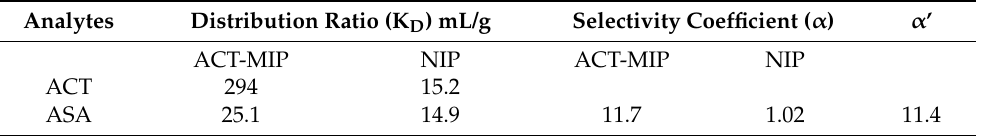
Table 7. Distribution ratio (K D ) and selectivity coefficient ( α ) values for ACT-MIP and NIP.